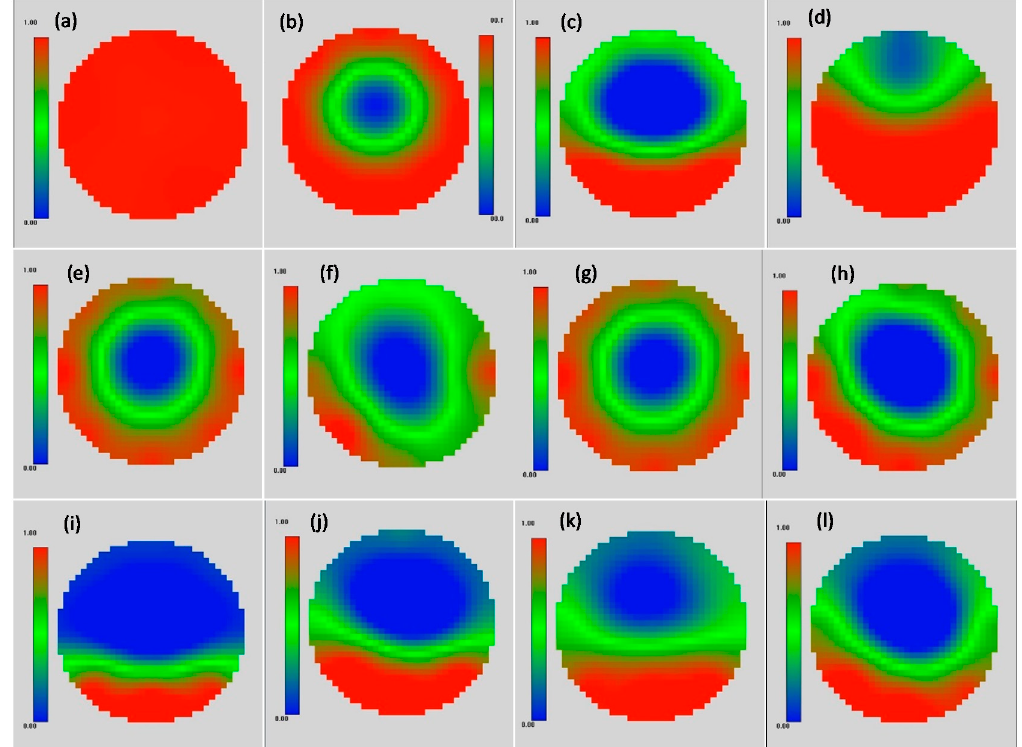
Figure 6. Evolution of fluid permittivity distributions calculated from electrical potential distributions for the sensor measurement cross-section of an area fraction captured by the ECT sensor for a typical experiment ( a – d ) corresponding to upward plug flow pattern at u ( L ) = 0.506 m / s and u ( G ) = 0.377 m / s, ( e – h ) corresponding to upward annular flow pattern at u ( L ) = 0.1333 m / s and u ( G ) = 5 m / s, and ( i – l ) the corresponding to horizontal stratified pattern at u ( L ) = 0.137 m / s and u ( G ) = 4.47 m / s, (Red = liquid phase, Blue = gas phase, and Green = interface between two phases).